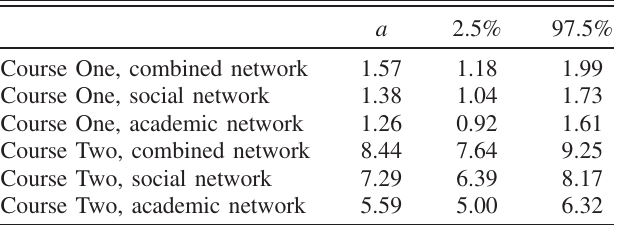
TABLE II. Estimation of parameter a in the generalized Gamma function with 95% confidence